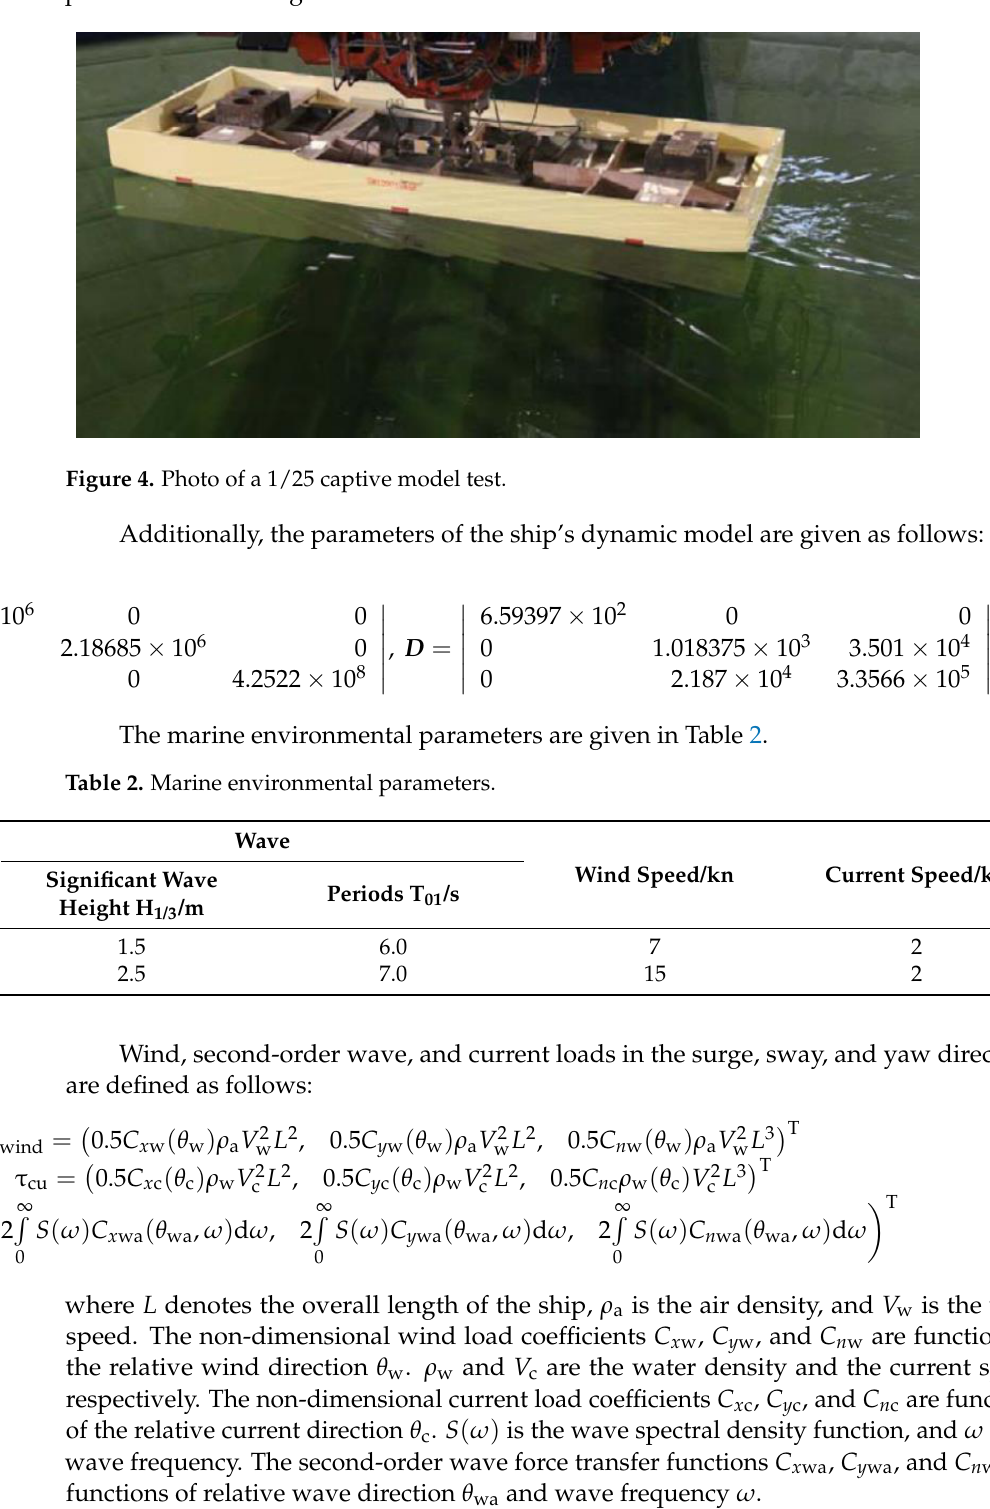
Figure 3. Sketch of thruster positions.